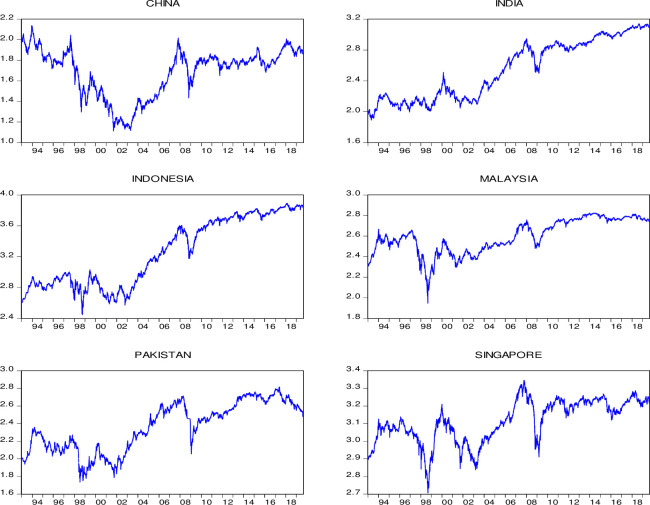
Dynamics of daily stock prices.